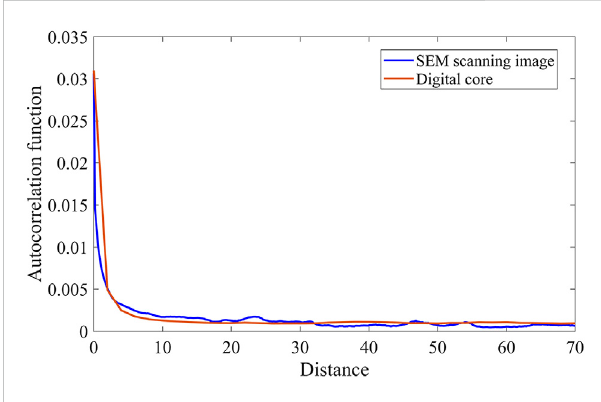
FIGURE 4 ComparisonbetweenautocorrelationfunctionsofSEMscanning image and digital core.